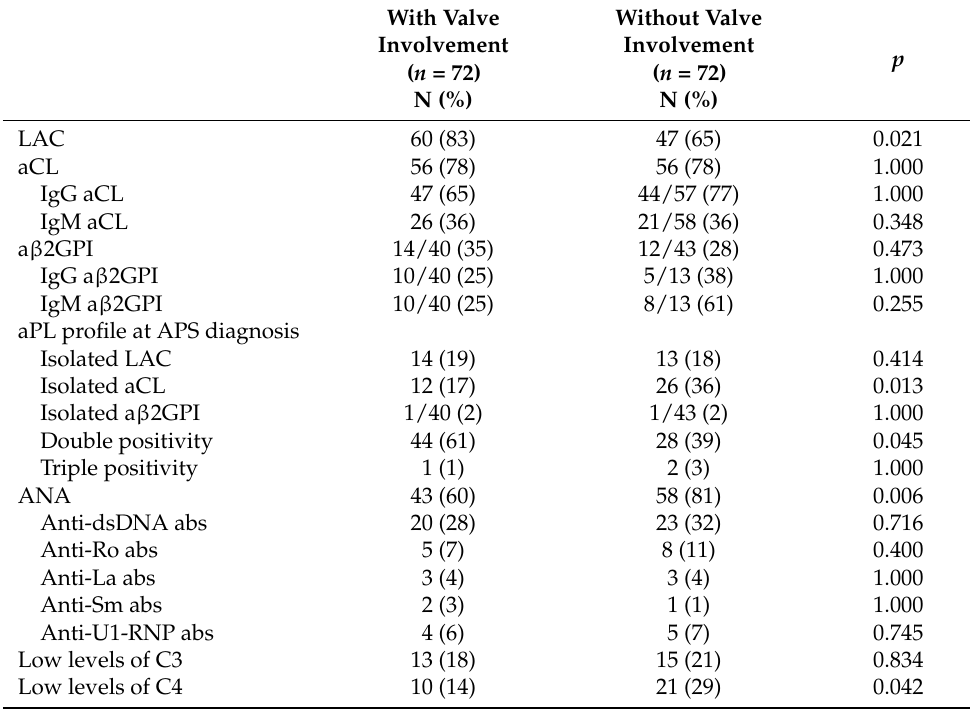
Table 2. Laboratory features of patients with antiphospholipid syndrome according to the presence of heart valve involvement detected by